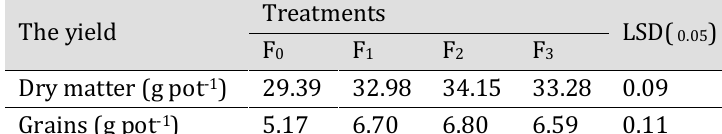
Table 4. Effect of fertilization with potassium and micronutrients on the dry matter and grains yield (g pot -1 ) of wheat